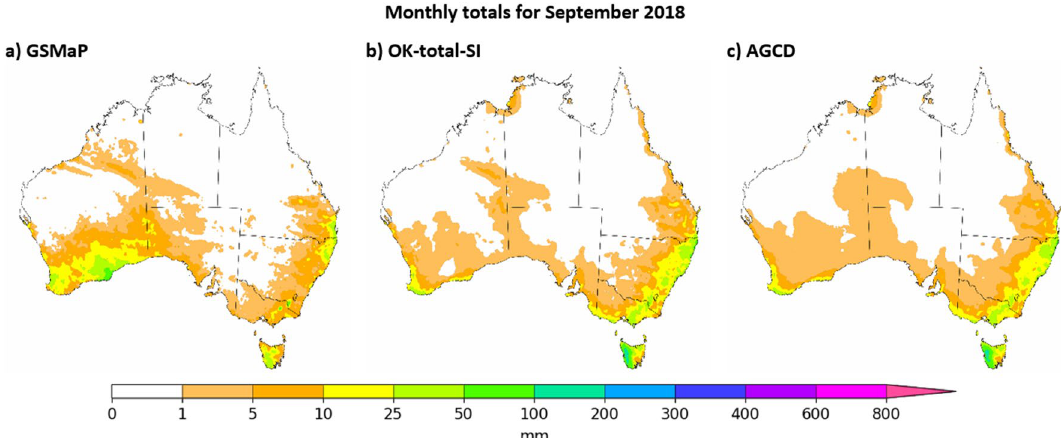
Figure 10. Visual comparison of September 2018 as represented by GSMaP-SI, OK-total-SI and AGCD. Figure created using Matplotlib 3.3.3 on